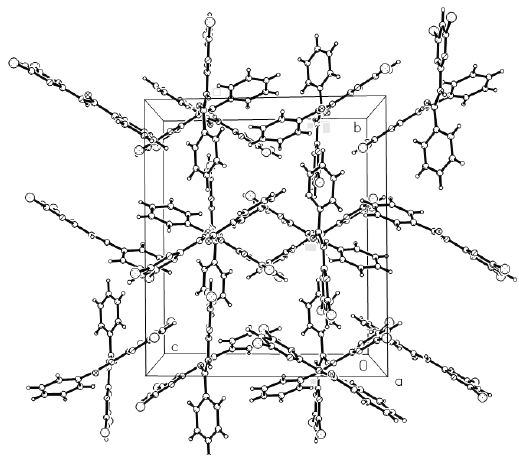
Figure 2. Packing arrangement of Compound 1 in the unit cell.